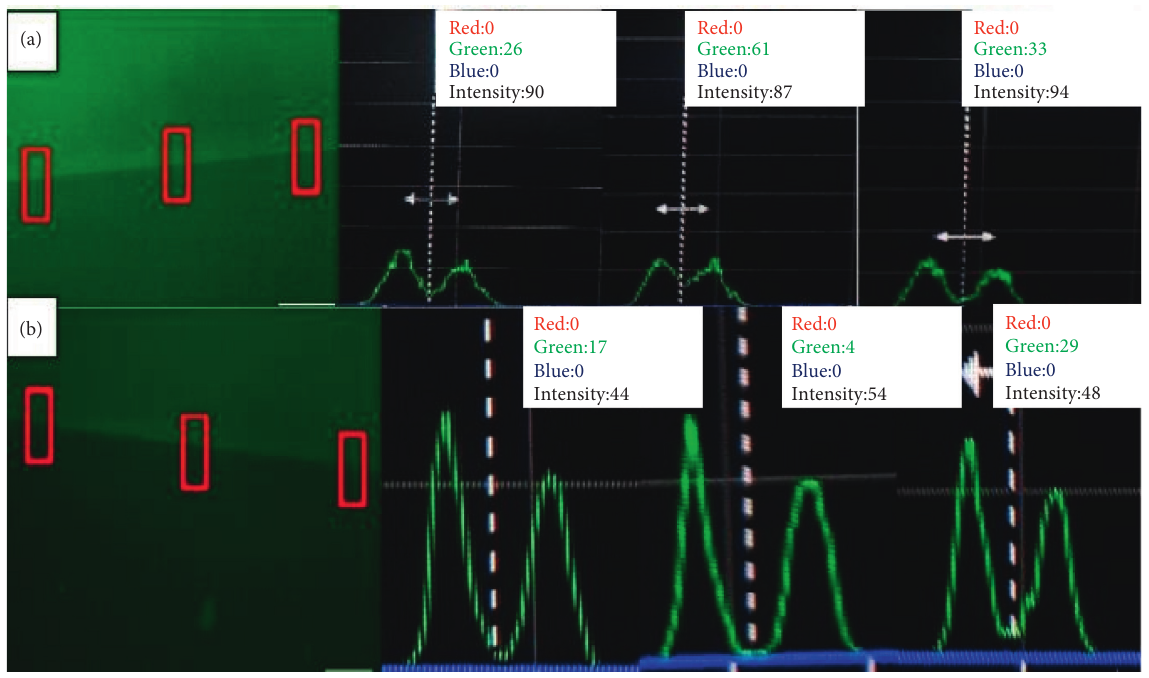
Figure 7: Histograms of MMP activity: (a) EDTA with Clearfil ™ and (b) EDTA with Adper Single Bond 2 ™ . Table 2: Comparison in relation to the experimental groups for each measure of the Clearfil ™ adhesive system, Manaus, AM. Measure Groups Left Middle Right Med Di Med Di Med Di Negative control 57.0 62.0 46.0 100.0 Chlorhexidine 37.0 101.0 Emulsion 37.5 0.668 0.874